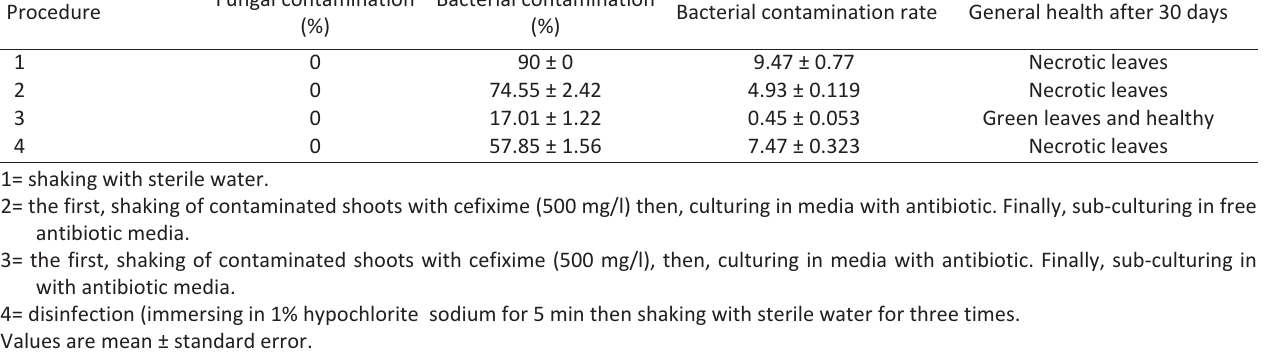
Table 3 ­ Analysis of variance of traits under